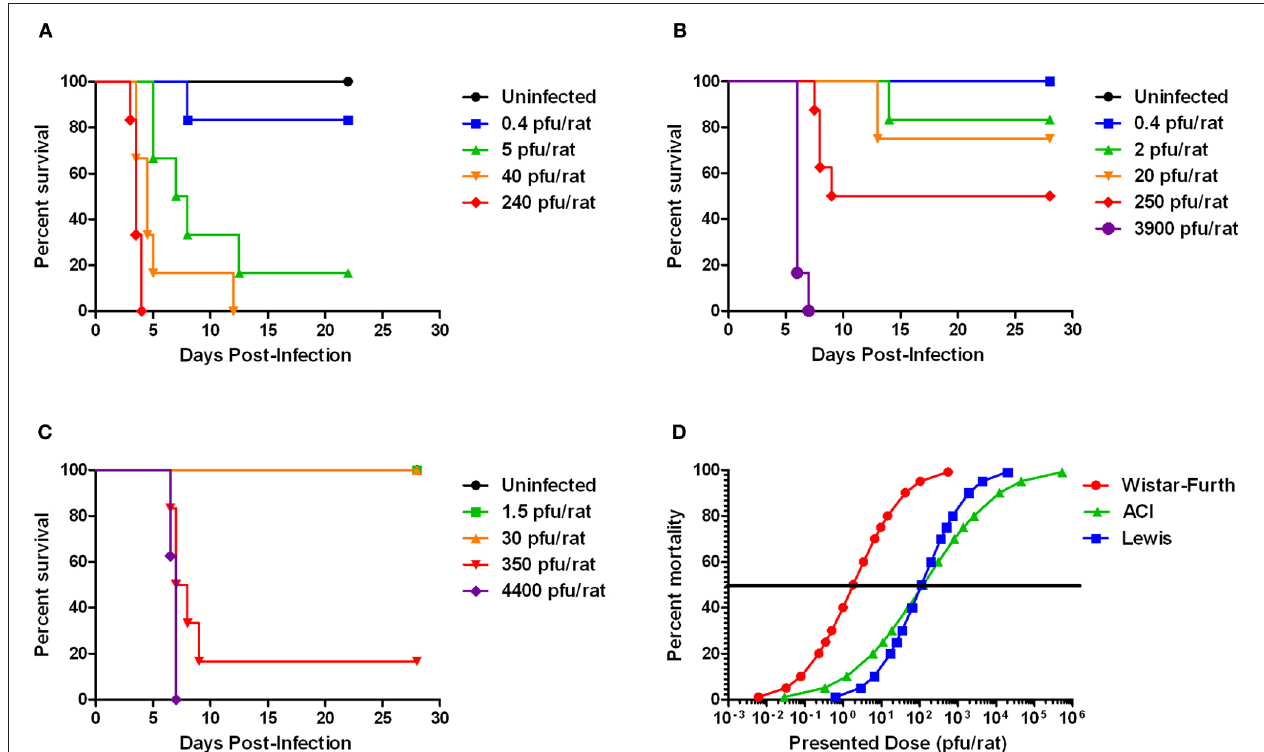
FIGURE 1 | Survival of three rat strains infected with aerosolized RVFV. Survival at each presented dose is shown. (A) Wistar-Furth, (B) ACI, and (C) Lewis. (D) Shows the probit curves for each rat strain, from which the LD 50 was determined.